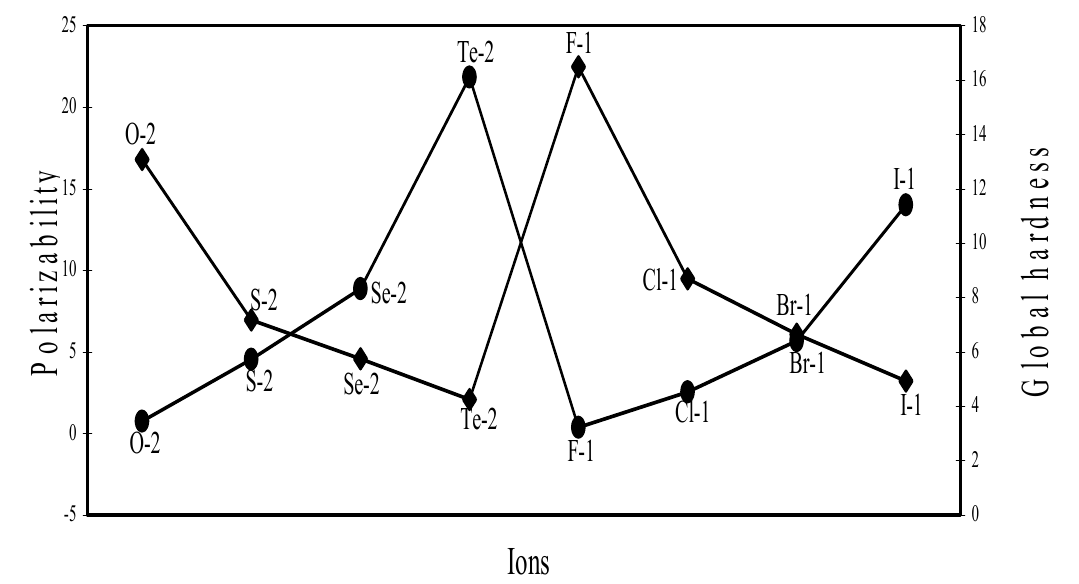
Figure 29. Plot of polarizability and global hardness of some common anions of Gr-VI and Gr-VII